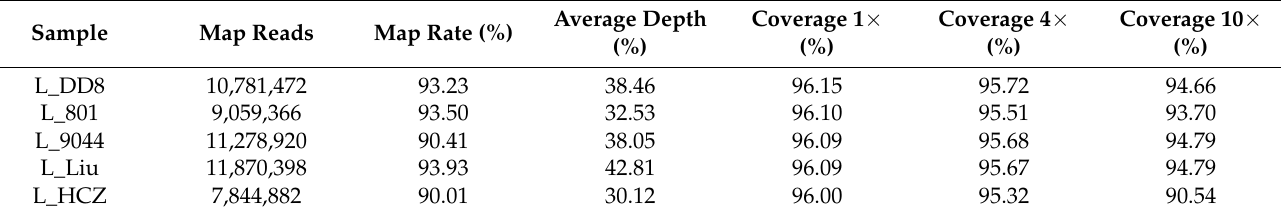
Table 3. Mapping results of the five Leishmania